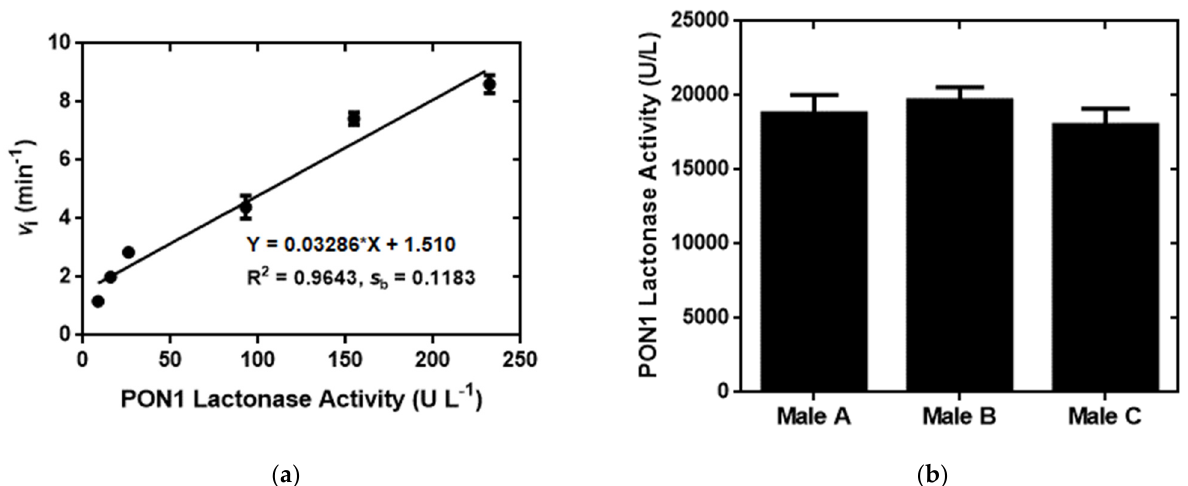
Figure 5. The 16b -based assay for the determination of PON1 lactonase activity in sera. ( a ) PON1 standards obtained from E. coli were analyzed using the 16b -based method that afforded the linear regression calibration curve of PON1 lactonase activity vs. initial velocity ( v i ), and gave an LOD of 10.8 U L − 1 and a linear detection range of 10.8–232.1 U L − 1 . ( b ) PON1 lactonase activity in serum samples from three healthy males was measured using the 16b -based assay. Please see Section 3.4 for the experimental details. Each reaction was analyzed at least three times in order to acquire the averaged values and standard deviation (the error bar) of v i or PON1 lactonase activity.